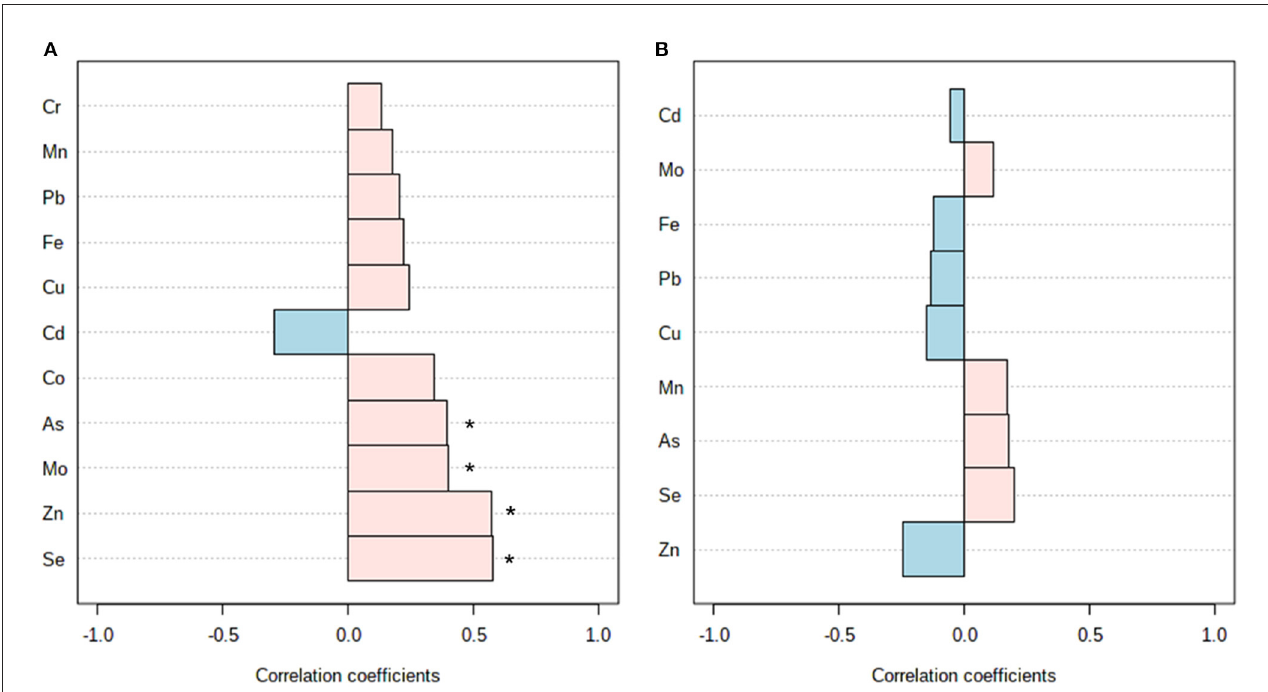
(e.g., consumption of a second vegetable, cereals) and zinc (e.g., consumption of pasta/rice) levels (Supplementary Figure